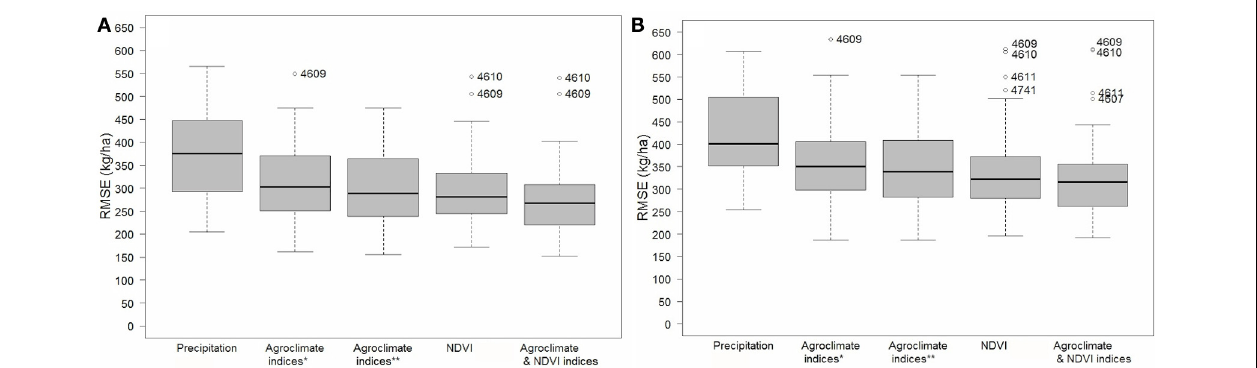
FIGURE 5 | Sensitivity of forecast error (i.e., Root-mean-squared error variance, RMSE) for different combinations of selected agroclimate variables and NDVI. (A) Forecasted yield in 2012, and (B) cross-validated (LOOCV) (i.e., backcasted) forecast yield. The predictors sets considered in each run were: Precipitation (P); agroclimate variables of crop water deficit